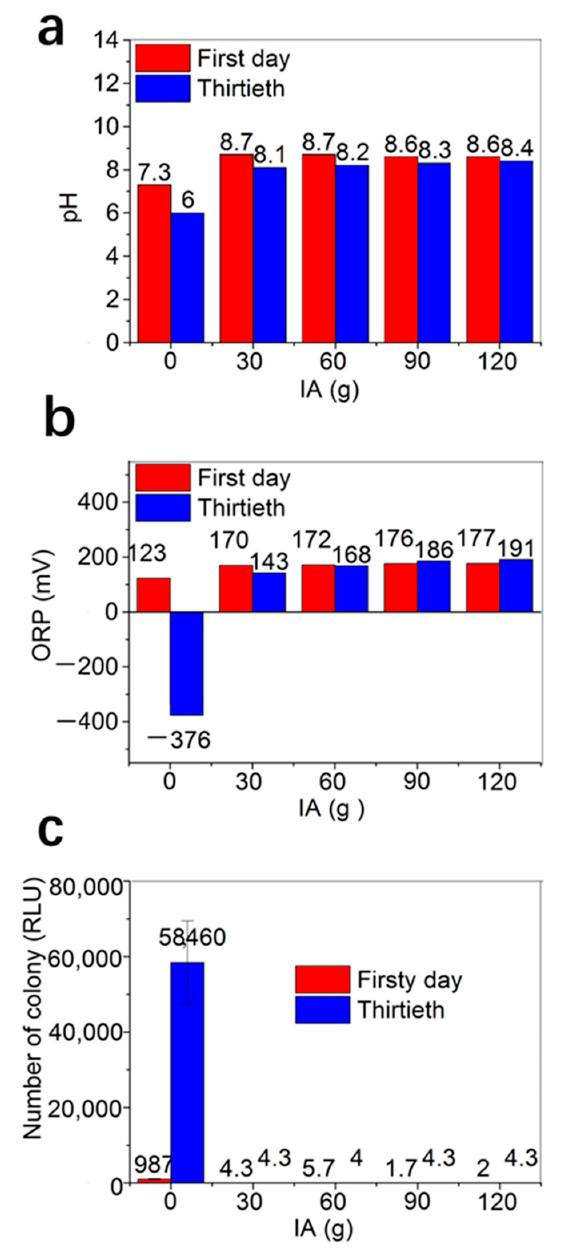
Figure 3. The pH values ( a ), ORP values ( b ), and numbers of bacterial colony ( c ) of the fire-resistant paper pulps with different amounts of IA stored at room temperature (28–36 ° C) for 30 days in